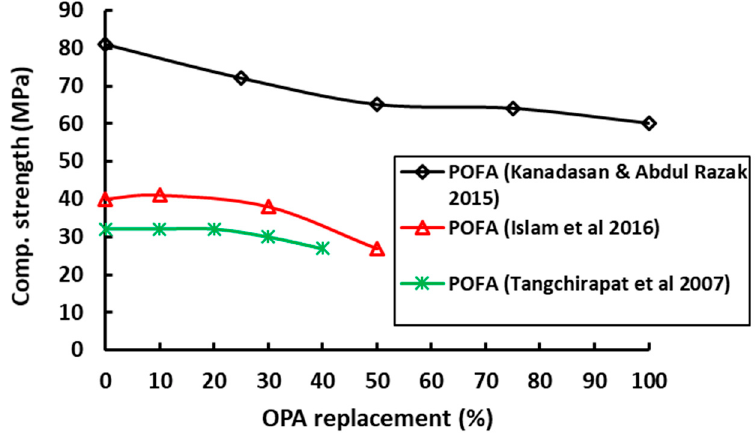
Figure 9. Influence of POFA on the compressive strength of concrete [26,30,71].